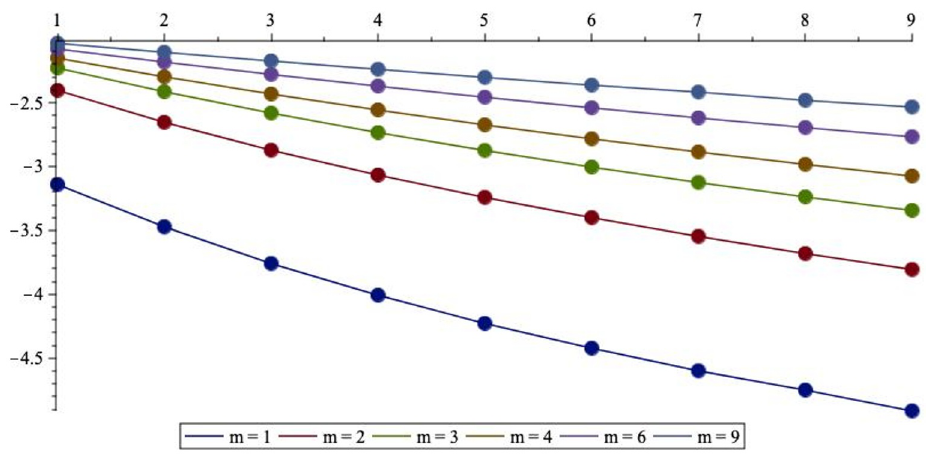
(cid:12) (cid:12) Figure 9. Plots of ln (cid:12) ω n +1 − ω n − π (cid:12) versus n for various values of m in asymptotically AdS toy model with a free scalar field. We have chosen ML = 1 for